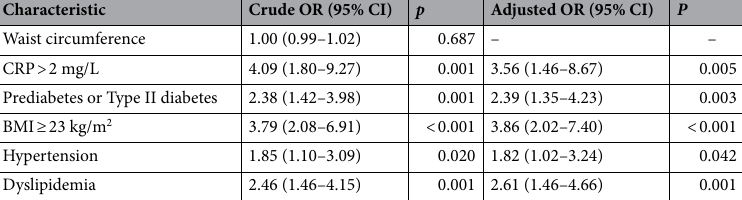
Table 5. Associations between metabolic traits and MAFLD-HCC in patients without cirrhosis on univariate and multivariate logistic regression analysis. FIB-4 fibrosis-4, BMI body mass index.